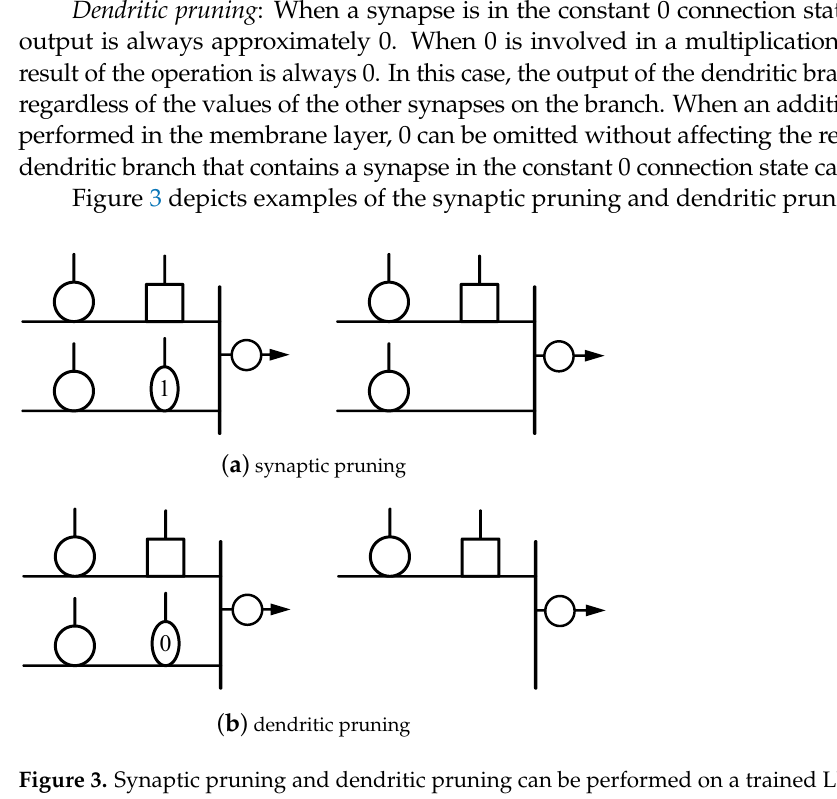
Figure 3. Synaptic pruning and dendritic pruning can be performed on a trained